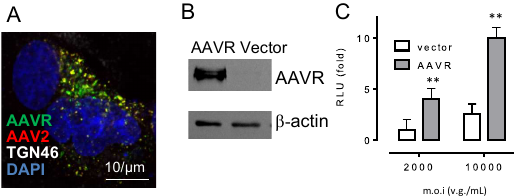
Figure 2. AAV2 bound to its high-affinity receptor AAVR enhanced viral transduction. ( A ) AAVR (green) concentrated in the trans-Golgi regions (white) and colocalized with AAV2 (red) in HeLa cells. ( B ) Western blot of the AAVR in HeLa cells transfected with an AAVR overexpression plasmid. ( C ) The transduction of AAV2–luciferase (m.o.i = 2000 and 10,000 v.g./cell) was measured at 24 h post-infection in both control and AAVR-overexpressed HeLa cells (** p < 0.01, n = 4).